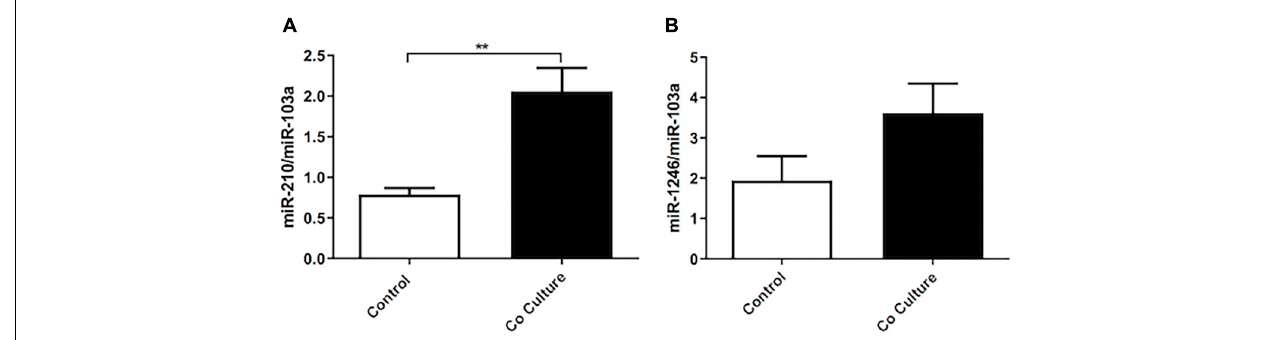
FIGURE 5 | Co-culture of epithelial cells increases the expression of miR-210-3p without affecting miR-143/145 or miR-25a. Total RNA was extracted from co-cultured or not co-cultured (control) ASMCs and RT-qPCR was performed to examine the expression of (A) miR-210-3p ( n = 9), and (B) miR-1246 ( n = 9). Data are representative of means + 1 SE. For RT-qPCR, Student’s paired t -test was utilized. ** P < 0.01.